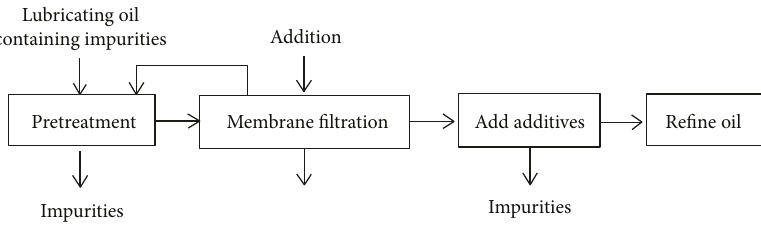
Figure 2: Membrane separation process.